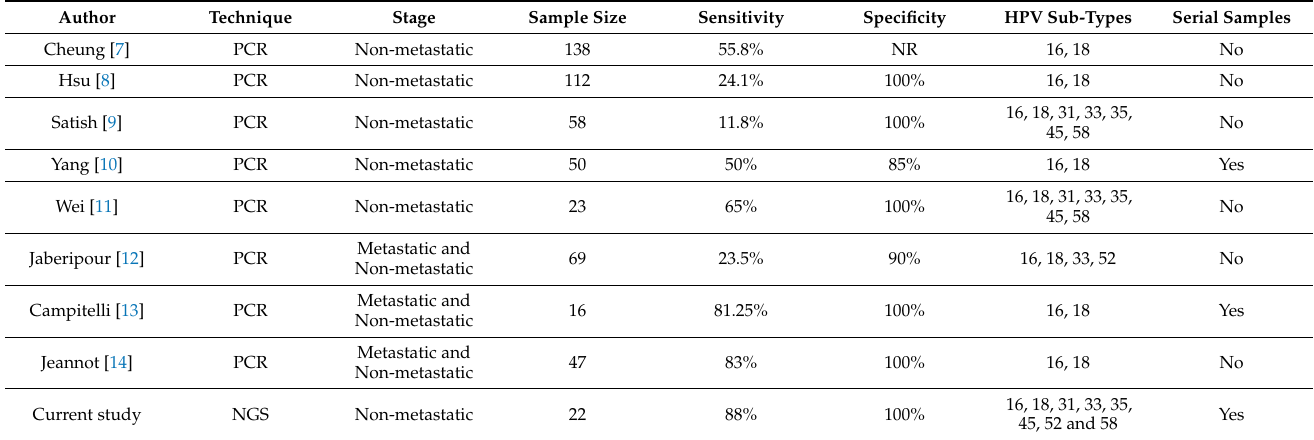
Table 5. Studies reporting PCR techniques for HPV DNA